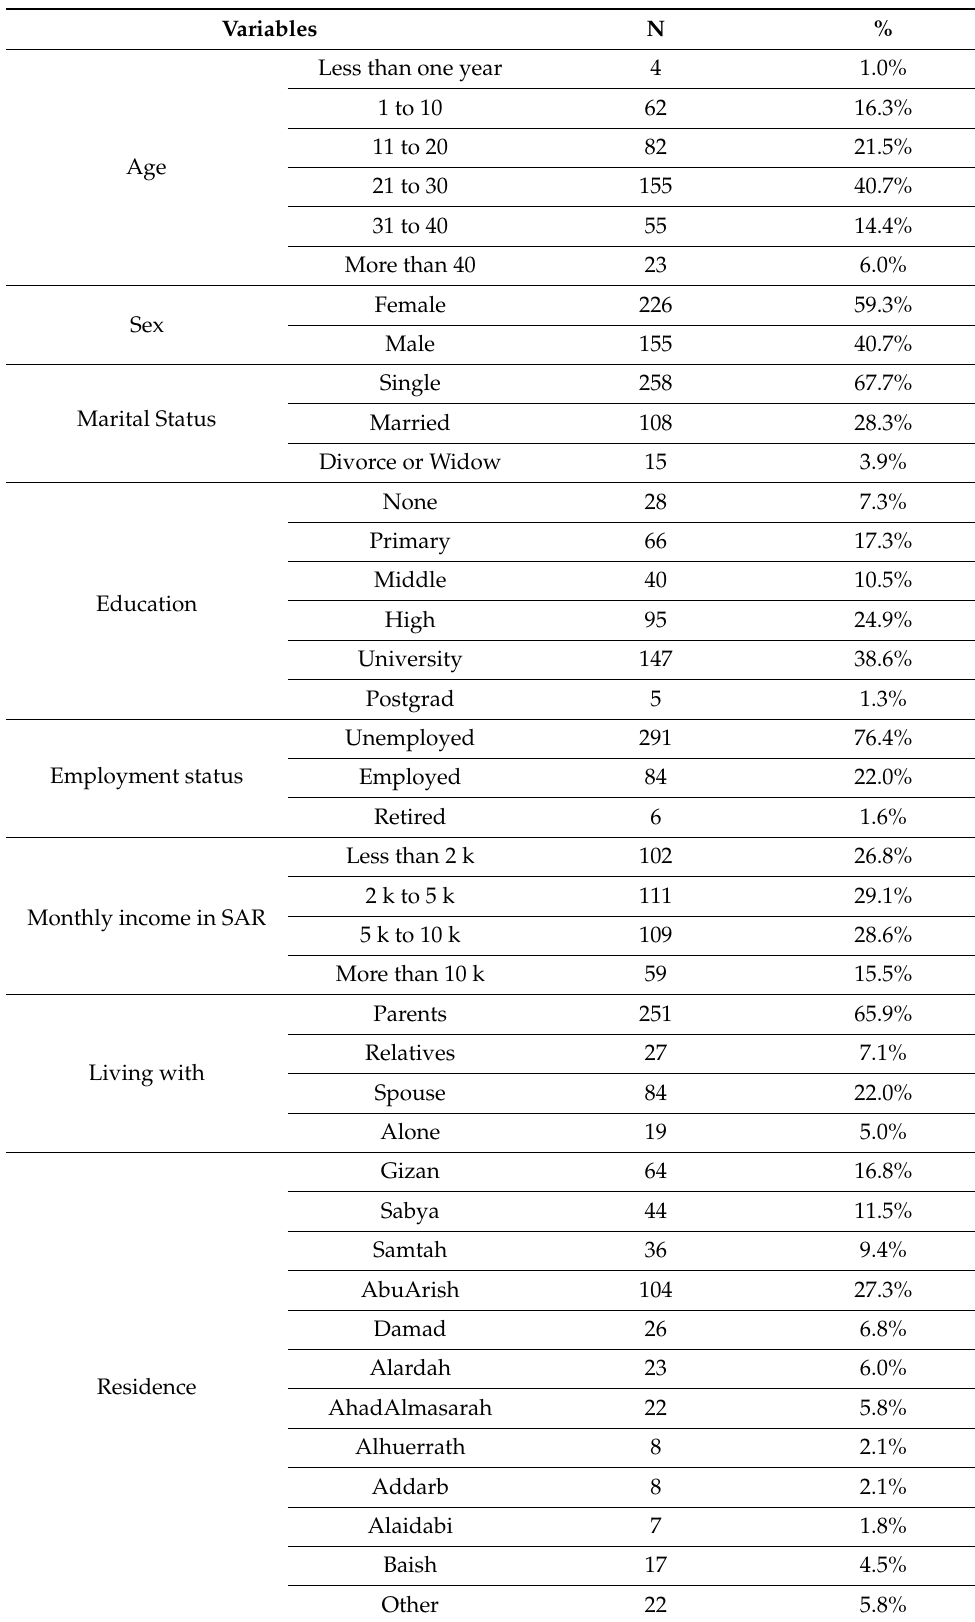
Table 1. Personal characteristics of the study participants ( n =